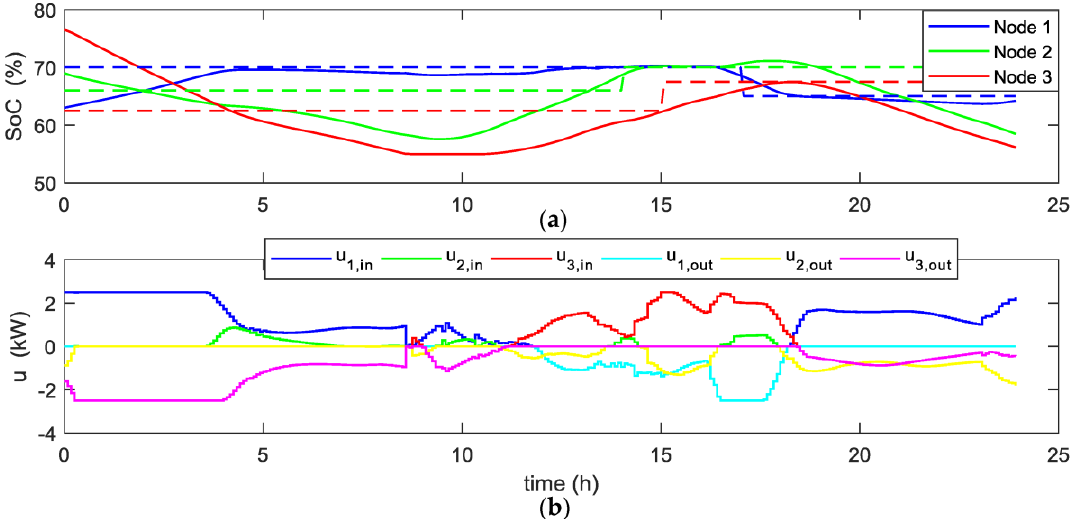
Figure 15. ( a ) Battery SOC at each node with NMPC enabled; ( b ) Control actions u applied at each time step at the DC/DC converters.